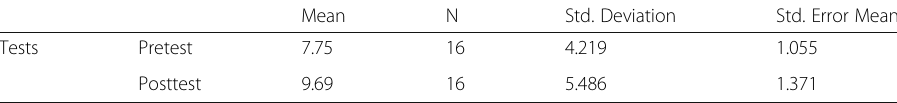
Table 8 Descriptive statistics; pretest and posttest of speech acts (in group feedback) Mean N Std. Deviation